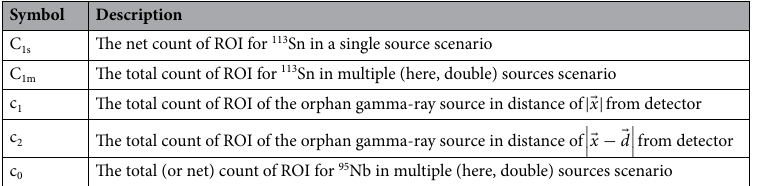
Table 2. The symbols used to explain an example for Eq.